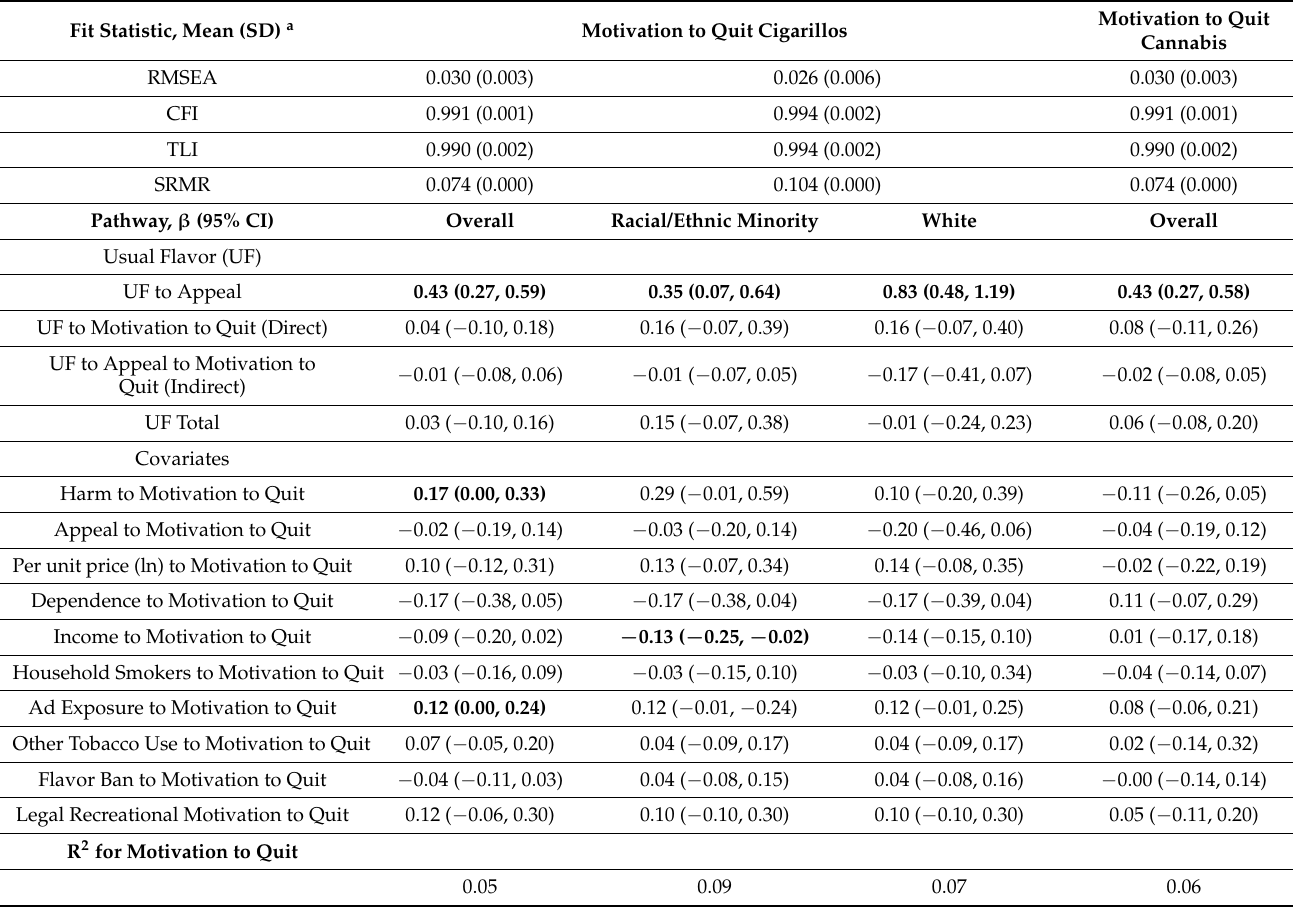
Table 3. Structural Equation Model Fit Statistics and Standardized Path